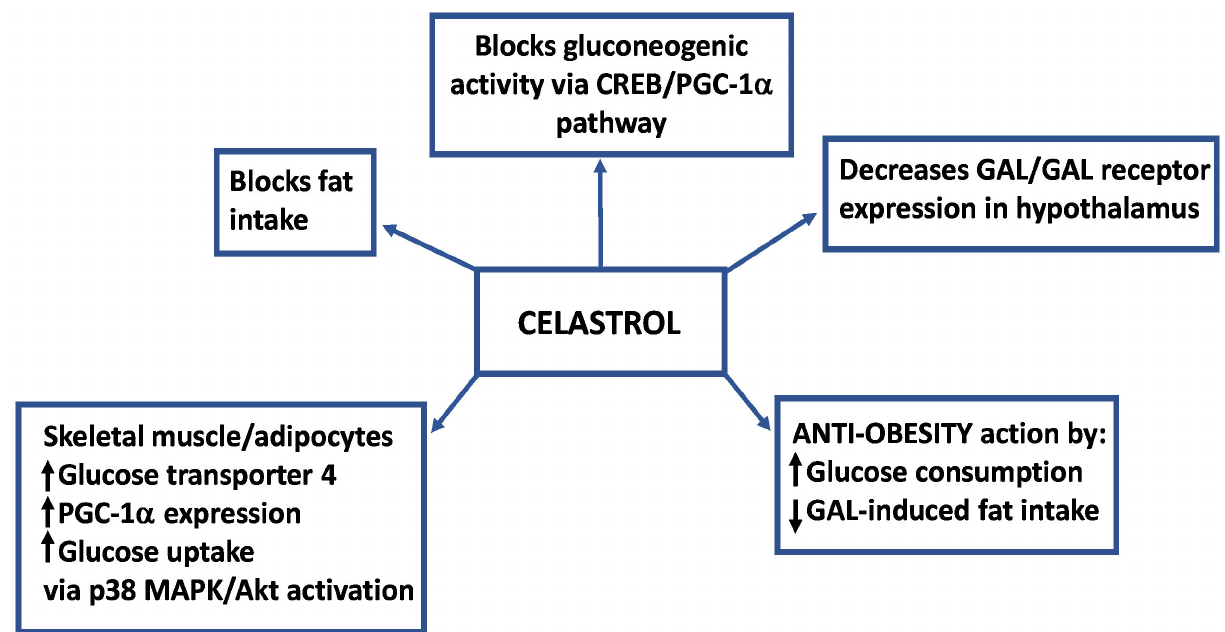
Figure 5. Effects of celastrol. ↑ : increase; ↓ : decrease. CREB: cAMP response element-binding protein; GAL: galanin; MAPK: mitogen-activated protein kinase; PGC-1 α : peroxisome proliferator-activated receptor γ